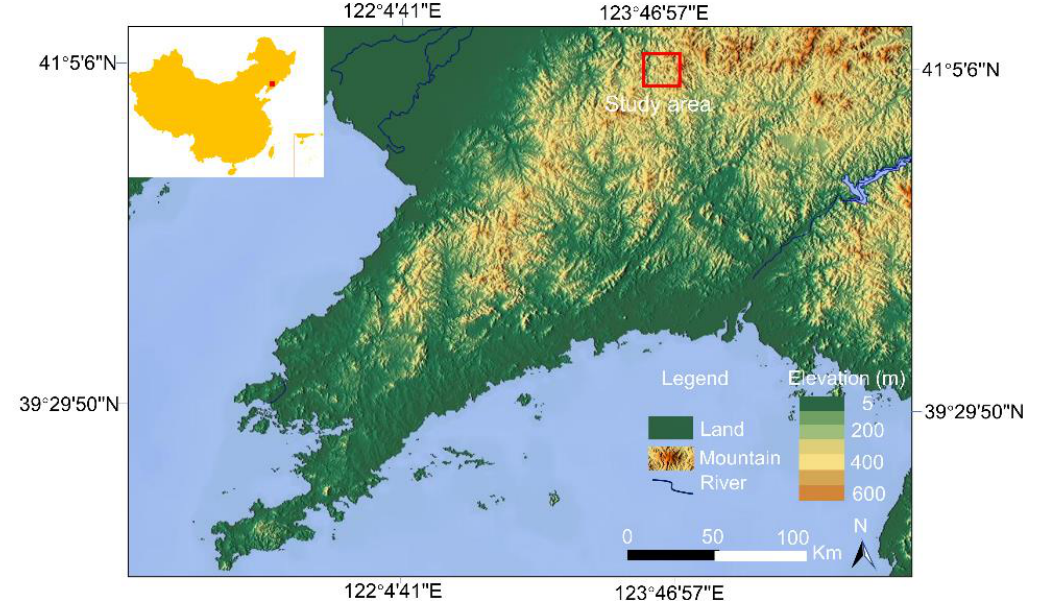
Figure 1. The study area of landslide of the full high waste dump.